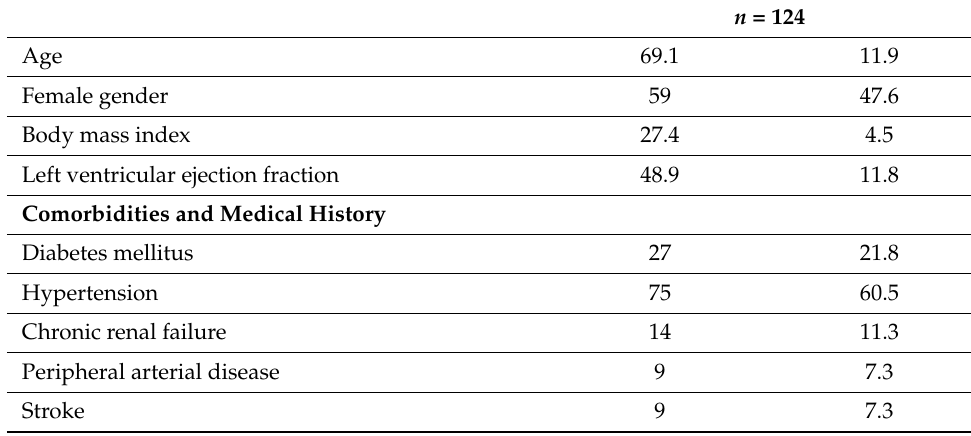
Table 2. Clinical and procedural characteristics of the dissection